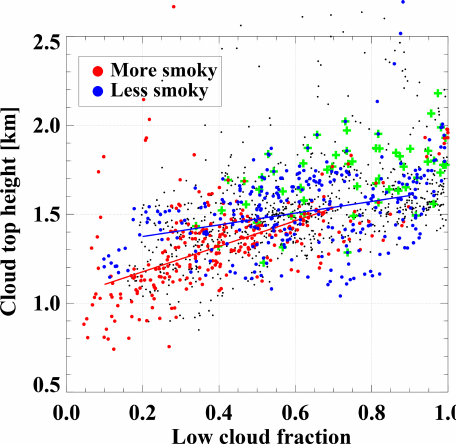
Figure 9. Hourly-mean SEVIRI-derived effective cloud top height as a function of low-cloud fractions over 6–10 ◦ S, 11–15 ◦ W. Cloud top heights corresponding to “more” and “less” smoky conditions are indicated in red and blue, respectively, and include linear fits as a function of cloud fraction. 08:00LST values are highlighted in green crosses regardless of smoke